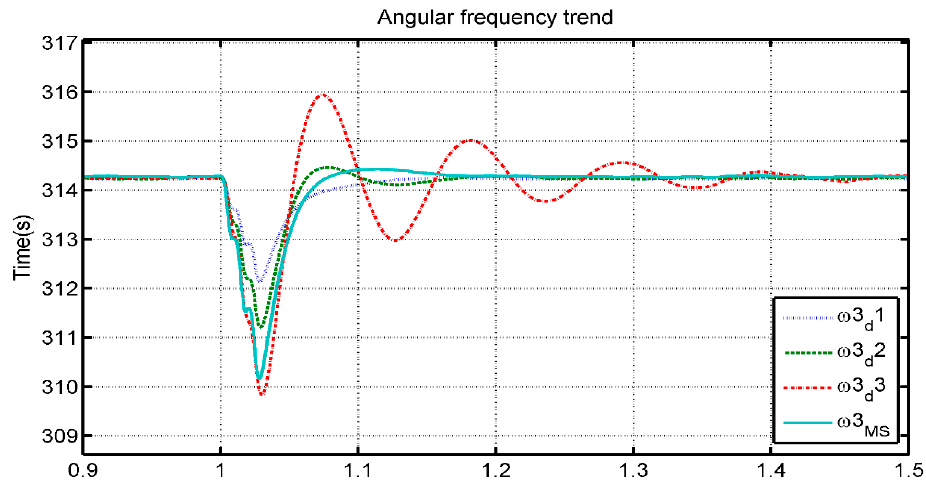
Figure 24. Comparison of angular frequency analysis under fault (VSG-3).